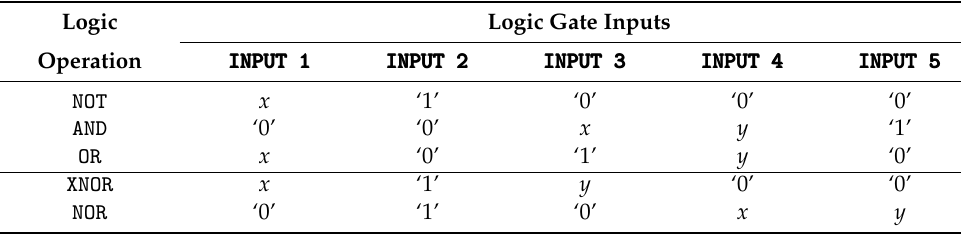
Table 1. Logic Gate Input Combinations for each Logic